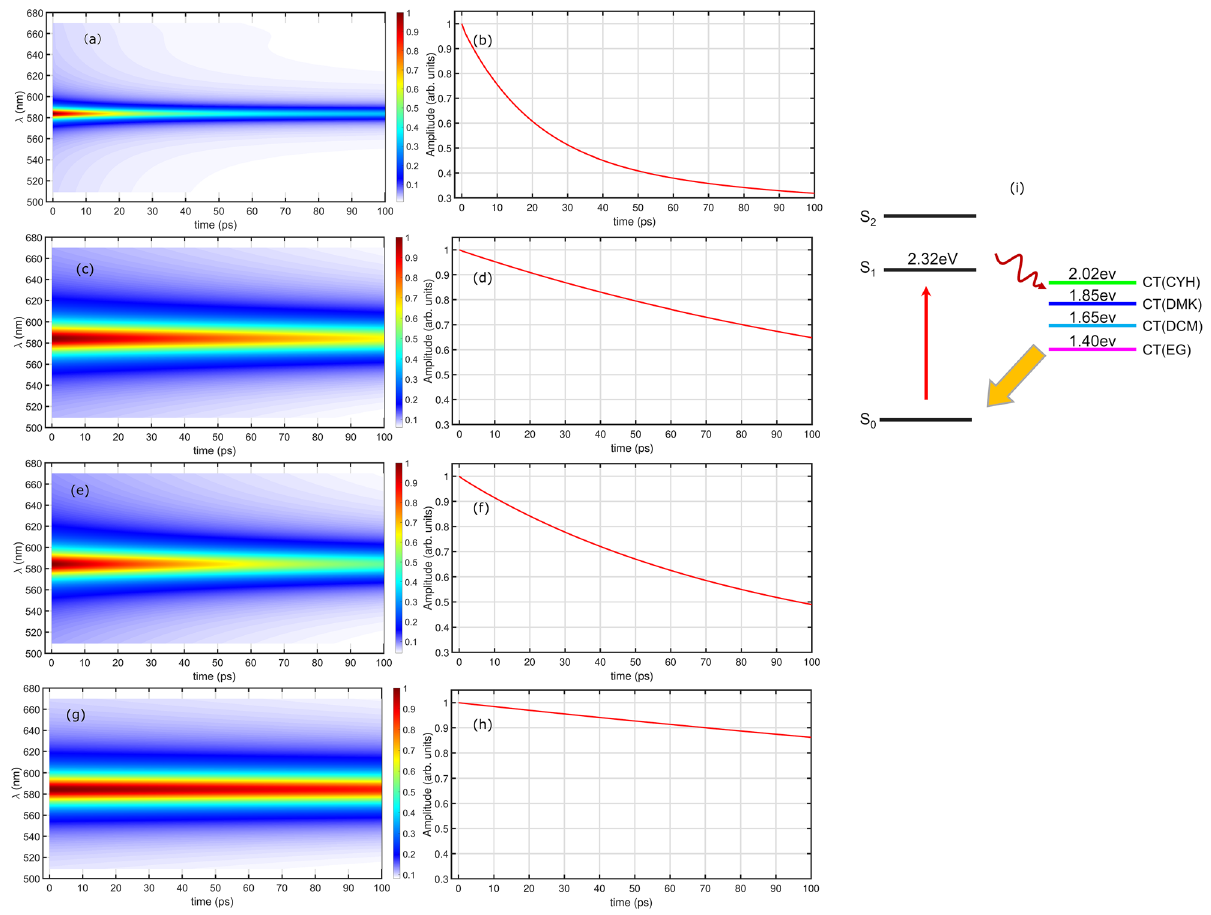
Figure 5. Calculation of transient absorption spectra of HB194 in different solvents. Calculated TA spectra of HB194 with CYH ( a ), DCM ( c ), DMK ( e ) and EG ( g ). The associated traces of GSB are shown in ( b ), ( d ), ( f ) and ( h ). The energy diagram employed for the calculations are presented in ( i